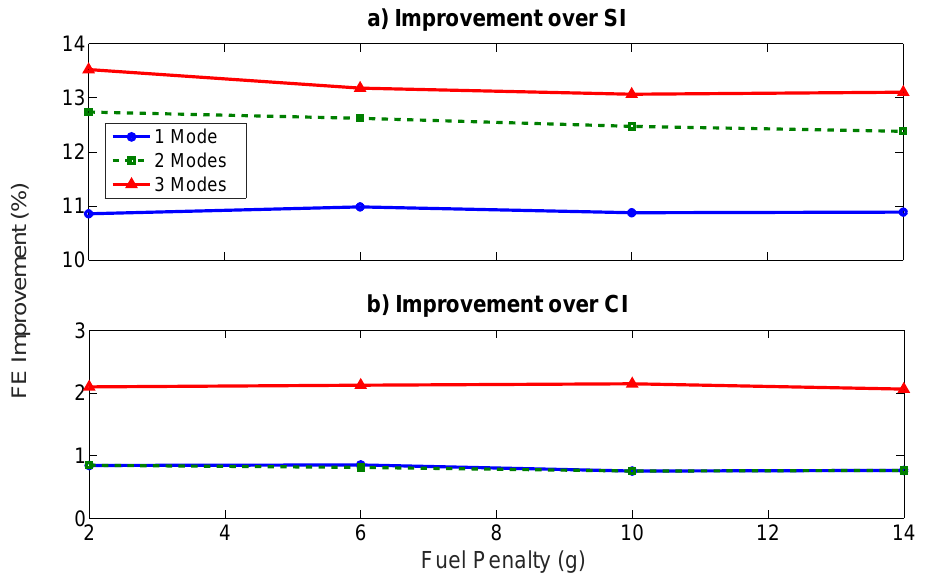
Figure 8. Fuel economy (FE) improvement by using RCCI versus ( a ) SI and ( b ) CI engines as a function of number of engine operating points and engine start-up fuel penalty. (EMC: DP).